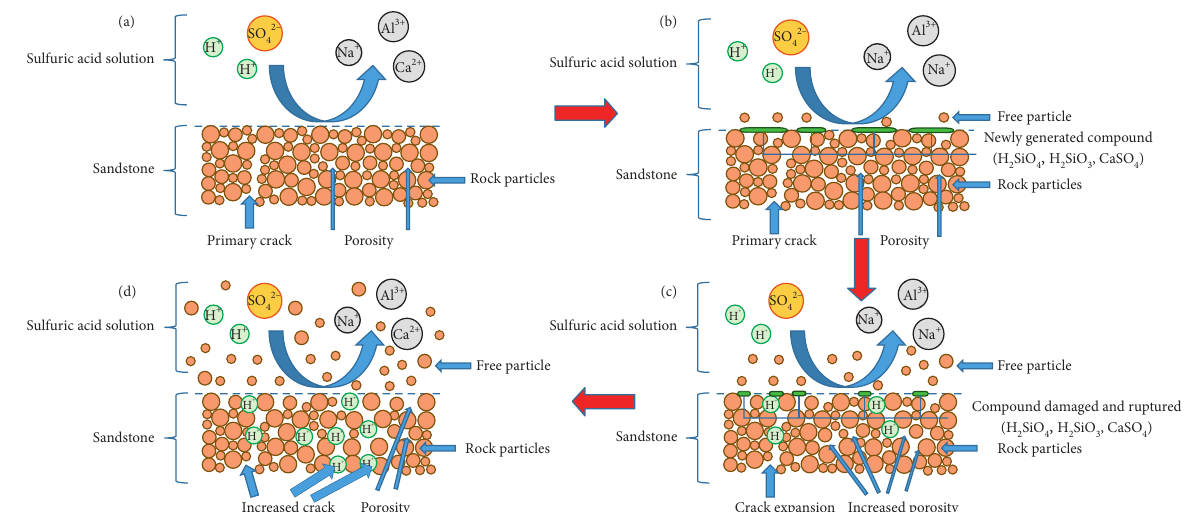
Figure 16: Sandstone damage mechanism: (a) Stage I, (b) Stage II, (c) Stage III, (d) and Stage